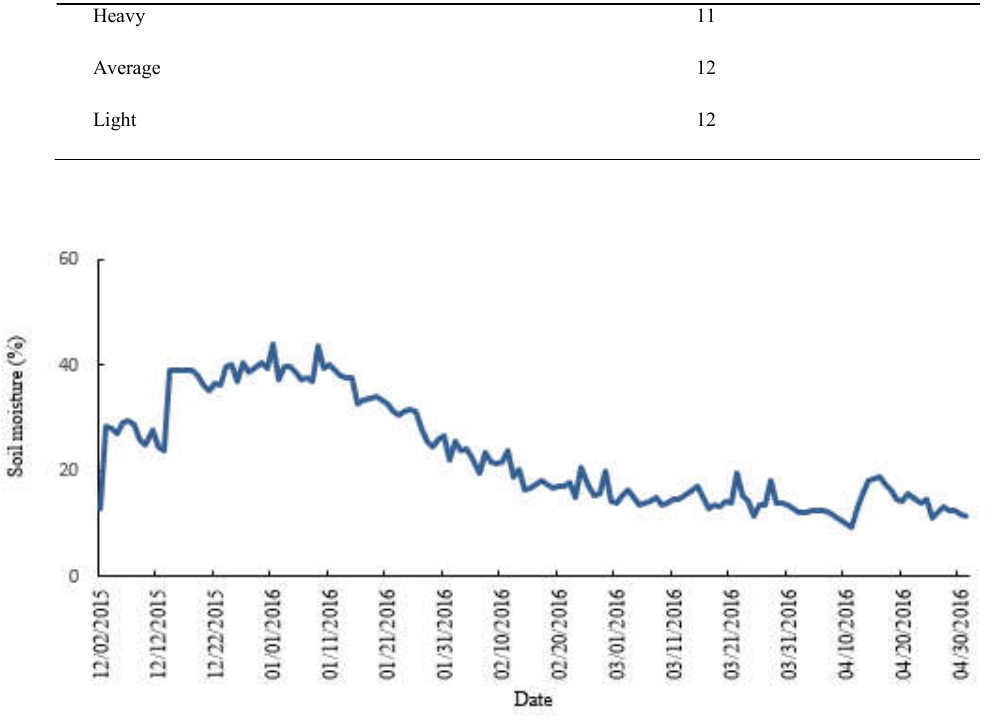
Fig. 3: Average changes of green roof soil moisture measurements during the study period